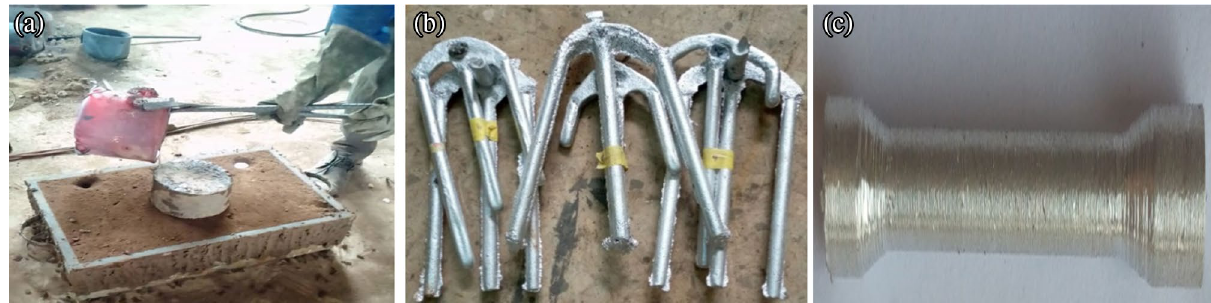
Figure 2. ( a ) Pouring of molten metal composite into prepared sand mold ( b ) solidified metal composite ( c ) tensile test sample.